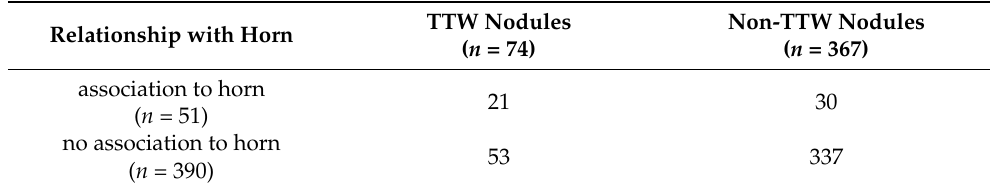
Table 2. TTW nodules and non-TTW nodules in association with a horn. TTW Nodules Relationship with Horn ( n = 74)